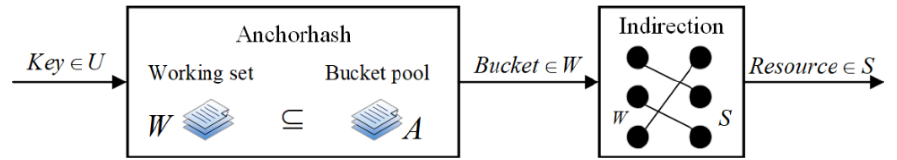
Figure 3. Anchorhash schematic diagram.